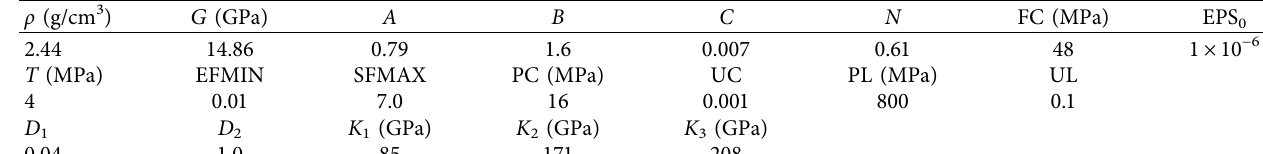
Table 4: Mechanical parameter of the